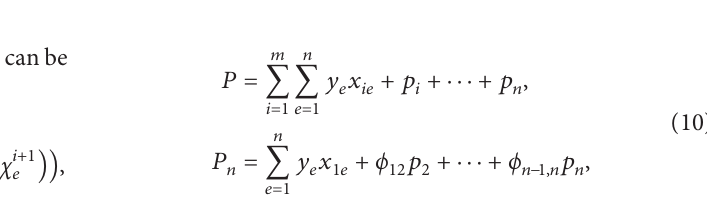
Figure 2: Management information